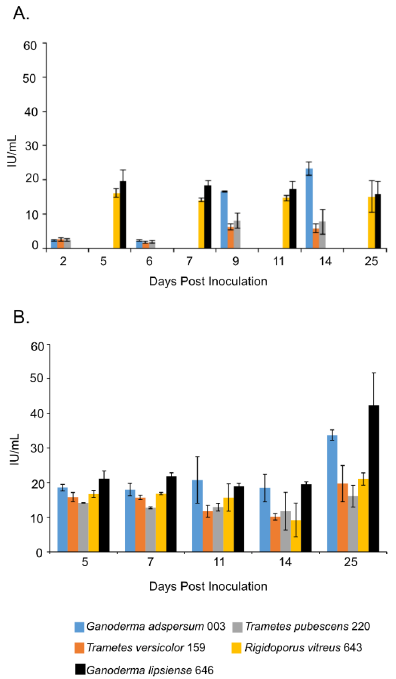
Figure 2. Endoglucanase activity at different days of incubation period of various white rot fungi when incubated with 2% ( w/v ) malt extract and TEMPO-oxidized CNF(0.017 wt%) and CNC(0.2 wt%) at 25 °C and 80% relative humidity. ( A ) Cultures were shaken at 120 rpm during incubation. ( B ) Cultures were initially shaken to stimulate growth but after 2 days they were left to stand for the duration of the experiment. Data represent an average of three biological replicates. J. Fungi 2021 , 7 , x FOR PEER REVIEW